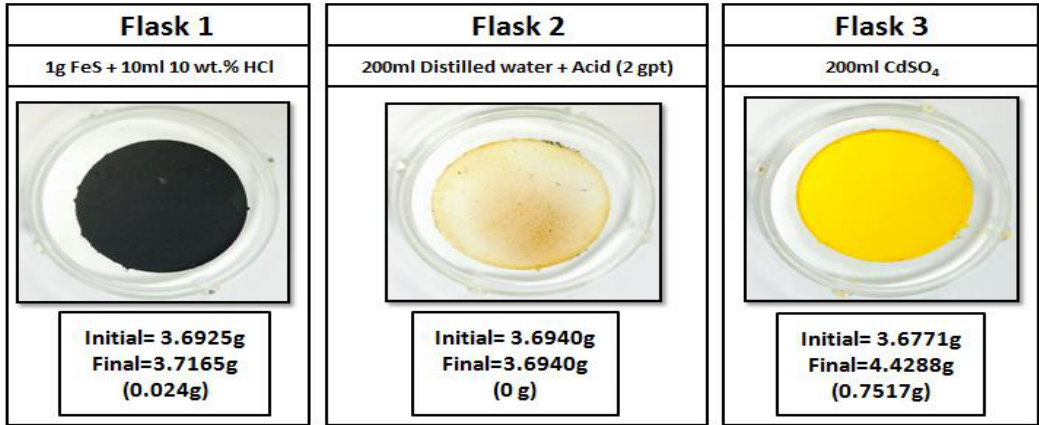
Figure 18. Acid gel breaker interactions in a sour environment for 4 h at 77 °F.